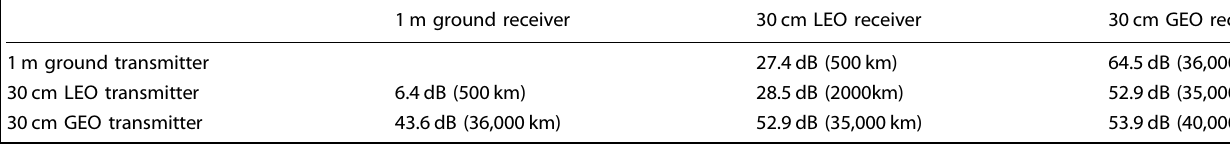
Table 1. Simulated link attenuation for 800 nm photons in various link scenarios 39